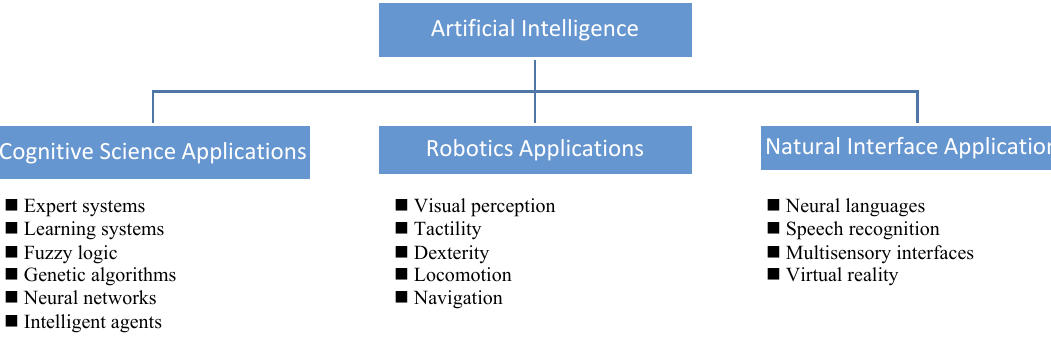
Fig. 1. The main applications of artificial intelligence (O'brien & Marakas, 2005,